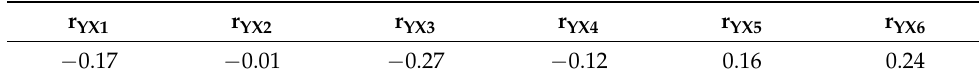
Table 4. Comparison of correlation coefficients values r j .